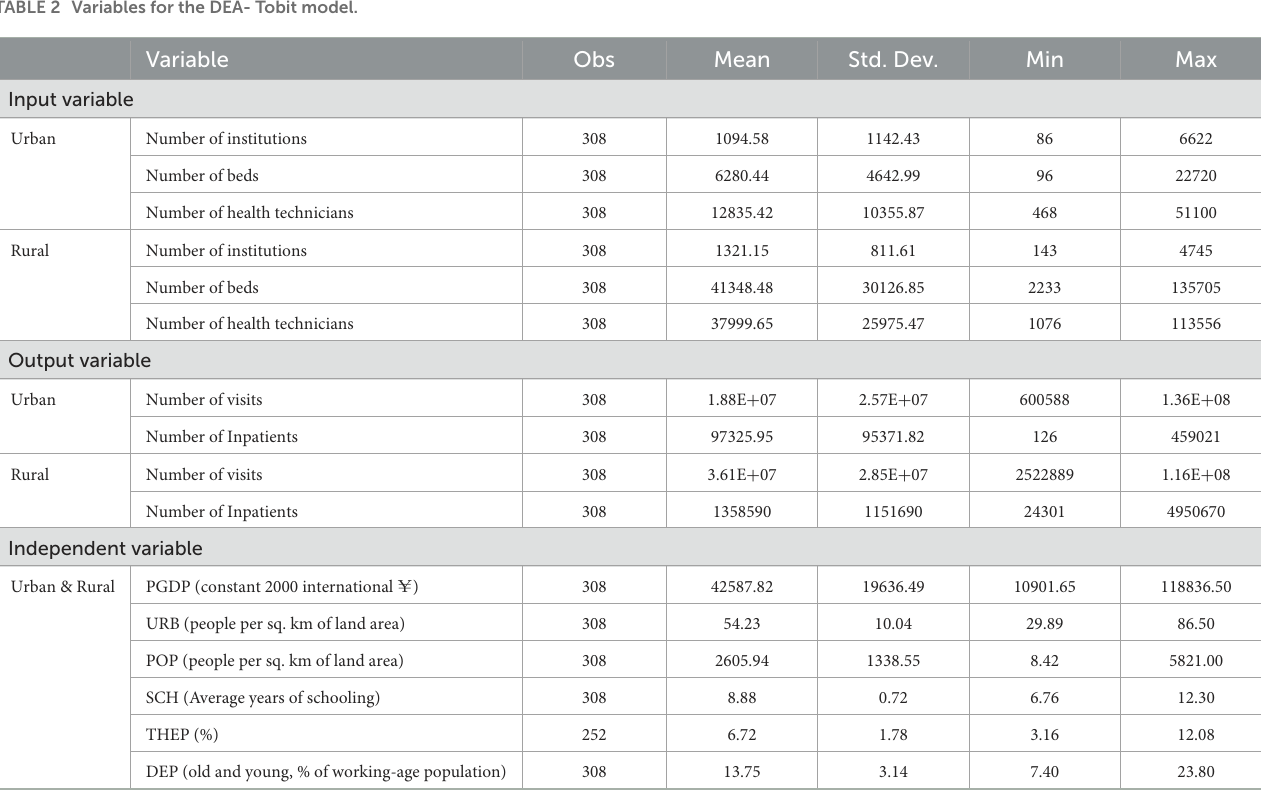
TABLE 2 Variables for the DEA- Tobit